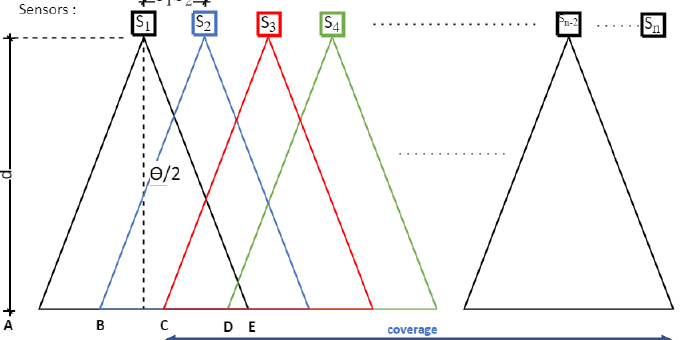
Figure 1. Sketch of sensor positioning respecting the visibility of a point on at least 3